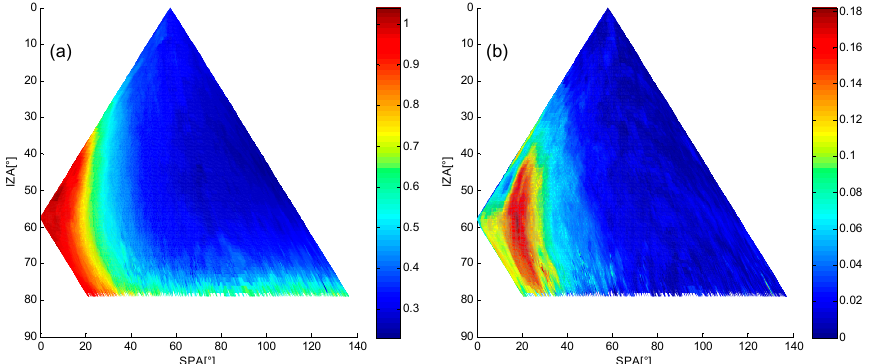
Figure 4. Distribution of RBR (red-blue-ratio) with SPA (Sun-Pixel Angle) and IZA (image zenith angle) in clear sky condition: ( a ) RBR distribution on 11 August 2015 at SZA = 58° (solar zenith angle); ( b ) standard deviation of RBR on 4 May, 10 June, 11 August and 24 November 2015 at SZA = 58°.